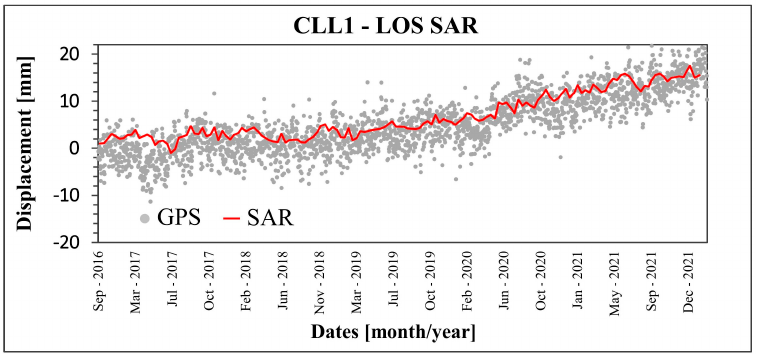
Figure 6. GPS and SAR time series, projected along the LOS SAR directions.